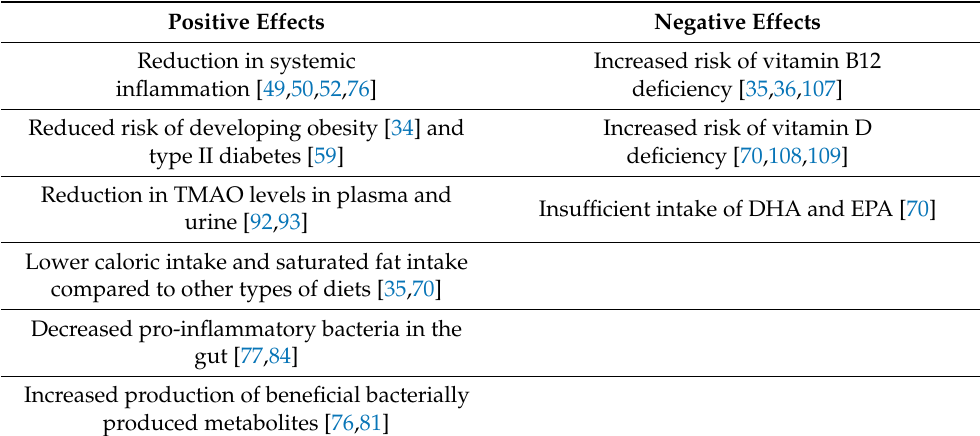
Table 2. Positive and negative effects of a vegan diet on Alzheimer’s